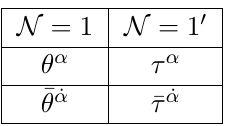
Table 2 . Goldstino modes of an instanton in Type II